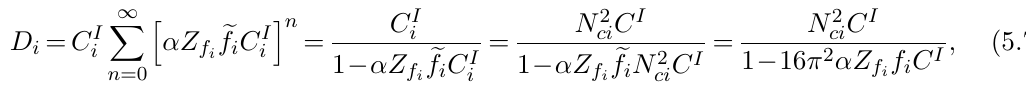
Figure 9. Blobs contributing to wave function renormalization for Φ 1 and Φ 2 . Each blob is made only of single trace couplings and propagators belonging to the corresponding